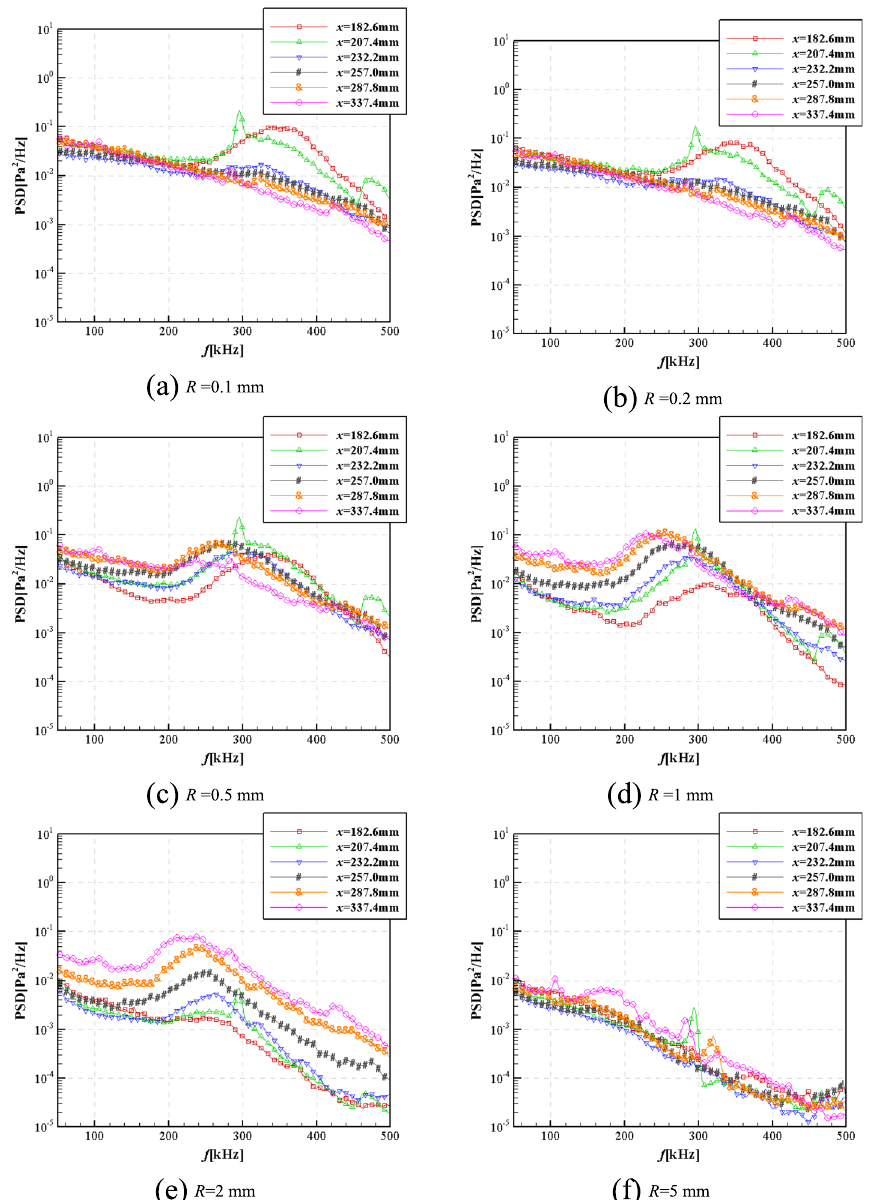
Fig. 11 PSD of wall pressure fluctuations at different cone bluntness. The wall temperature of the cone model is 300 K, the stagnation pressure of the wind tunnel is 10E the wind tunnel is 454 K, and the corresponding Reynolds number is 10E